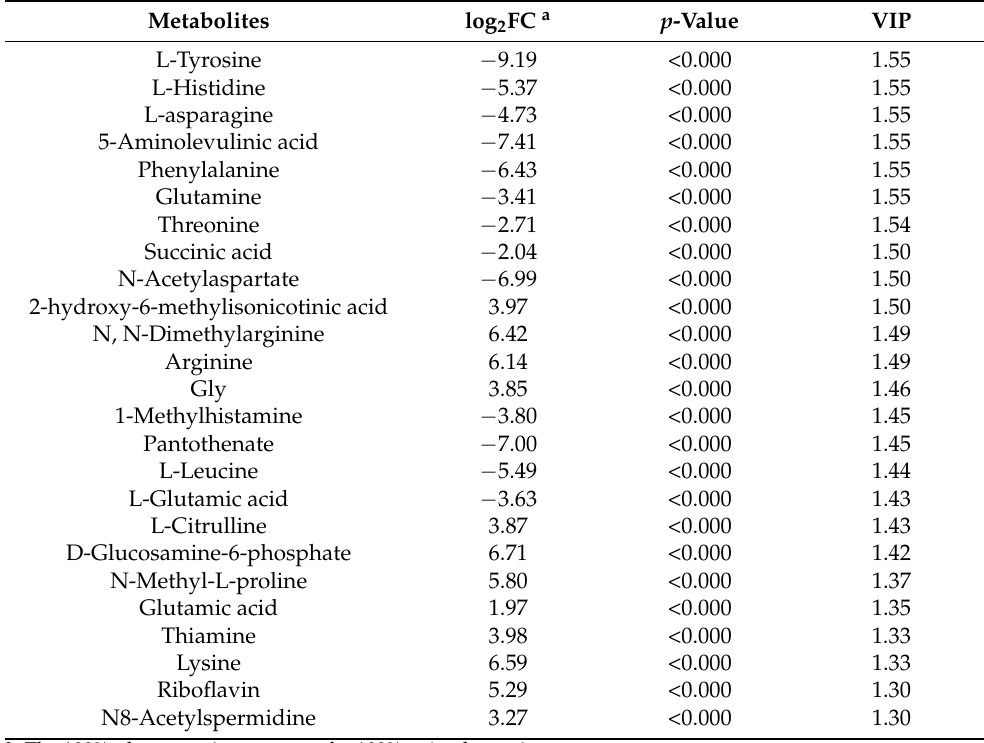
Table 7. Endogenous differential metabolites between the 100% plant protein group and 100% animal protein group.